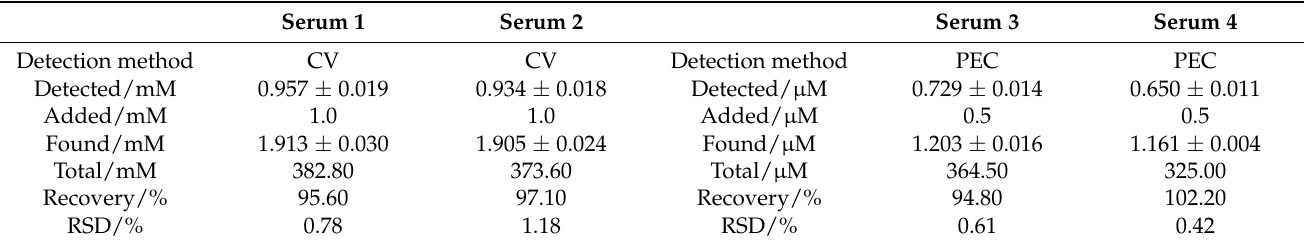
Table 3. Results of the determination of AA in different samples (n =